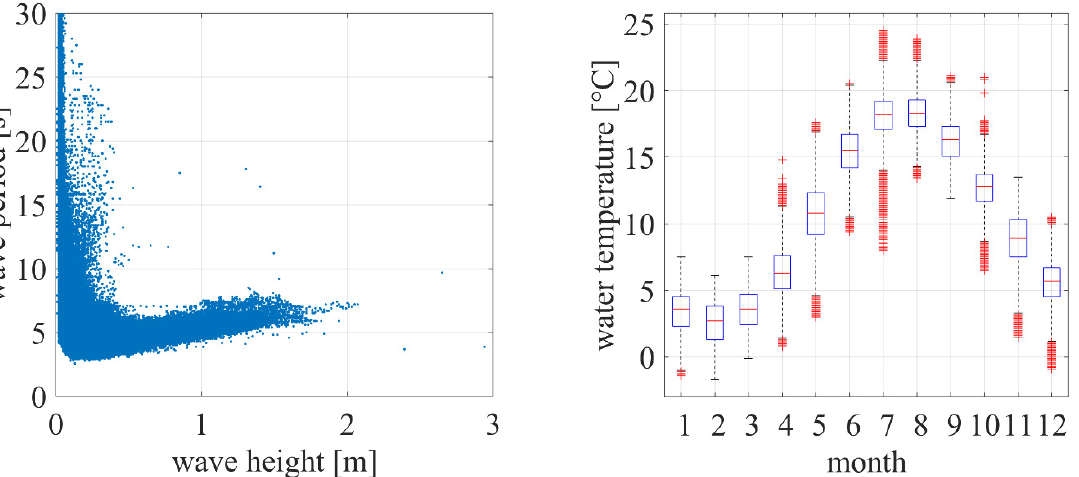
Figure 1. Wave periods as a function of wave height and the annual course of water temperatures at the study area Warnemünde (data source [41]).